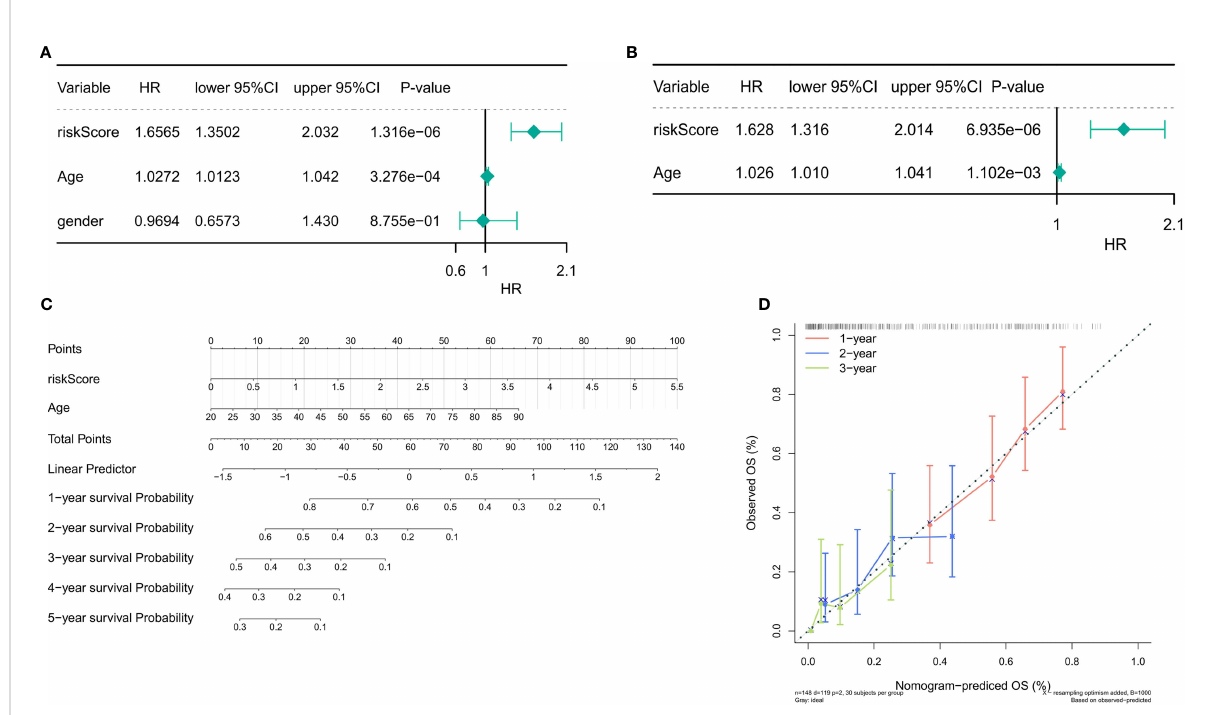
FIGURE 8 Independent prognostic analysis of the risk score. (A) Univariate Cox regression analysis in the training set. (B) Multivariate Cox regression analysis in the training set ( P < 0.05). (C) The nomogram designed with the risk score model and age (C-index = 0.66). (D) The 1 – 3-year calibration